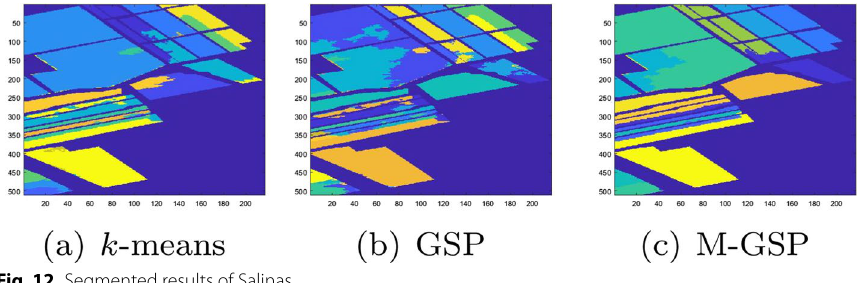
Fig. 12 Segmented results of Salinas